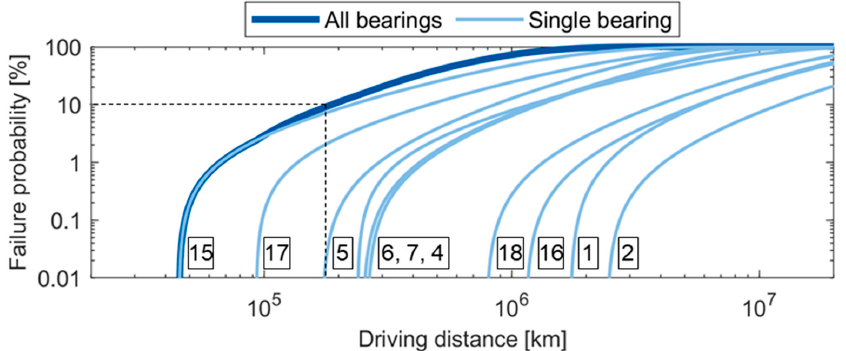
Figure 9. Failure probabilities of the individual bearings and the bearings as a group for the conventional drivetrain. The position numbers of the bearings are shown framed (see Figure 2). The dotted line indicates the B 10 -lifetime with 195,000 km.